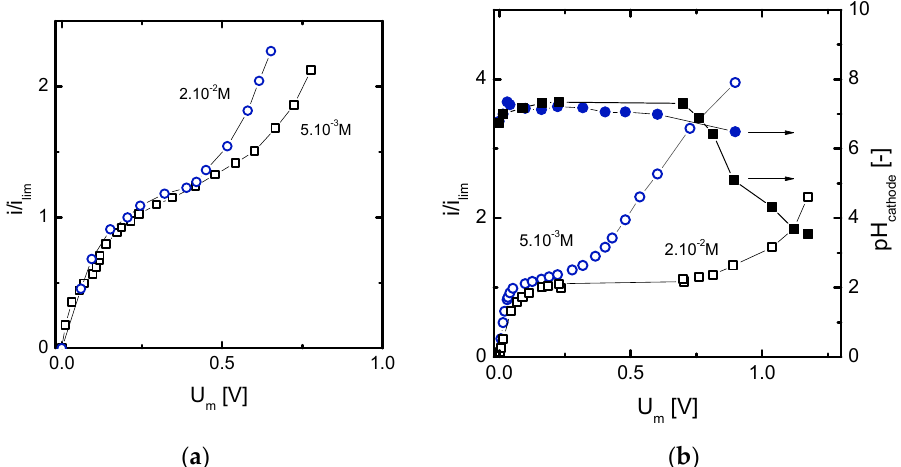
Figure 7. ( a ) Normalized current-voltage curves obtained for different solutions of Cr 2 (SO 4 ) 3 and ( b ) for different concentrations of NiSO 4 where different overlimiting mass transfer mechanisms occur.